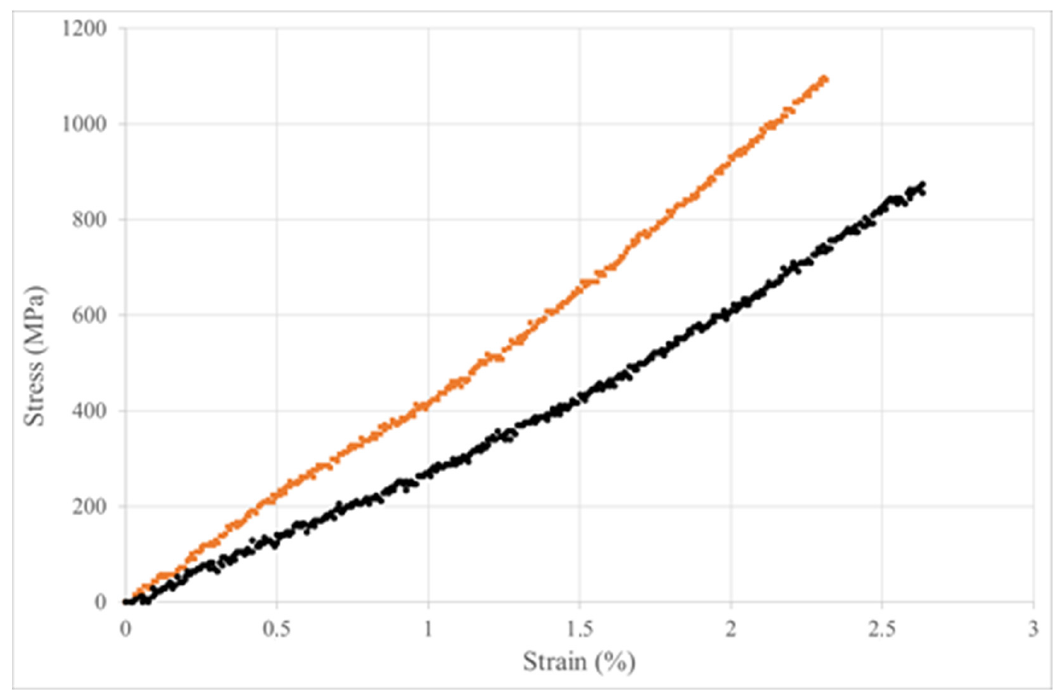
Figure 4. Examples of typical linseed flax stress–strain curves used to determine tensile properties of single elementary fibres. Table 8. Tensile properties, minimal diameter, maximal diameter and cross-section area of individual fibres coming from the four studied batches and tested after extraction, using both methods A and